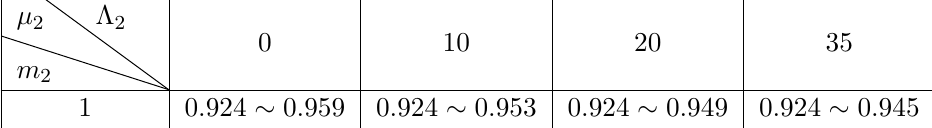
Table 3 . The domain of existence of the mass µ 2 of the scalar field φ 2 with various values of the coupling parameter Λ 2 . All solutions have µ 1 = 1 , m 1 = 1 , and m 2 = 1